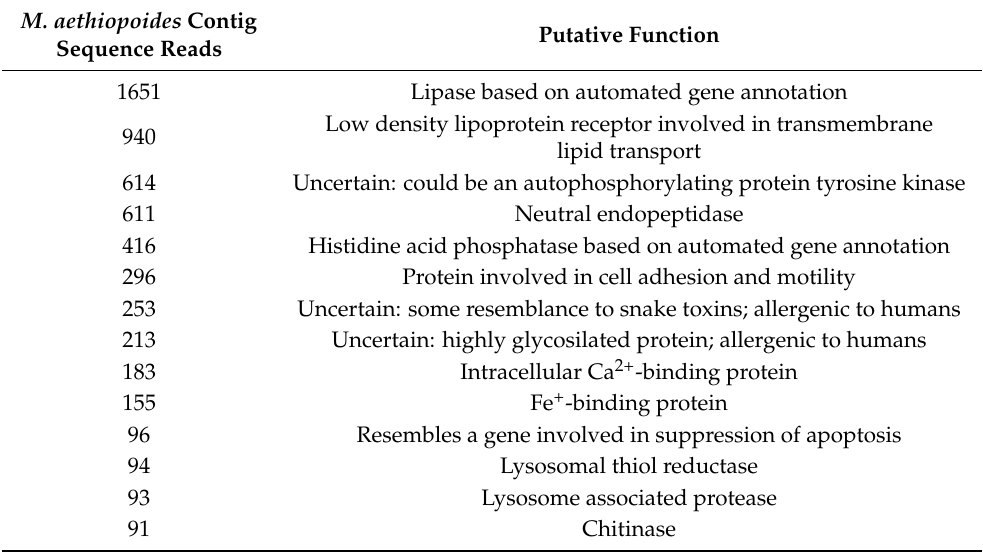
Table 7. The 14 most abundant RNA transcripts from Microctonus aethiopoides VGs (Source: data from Table 5 in